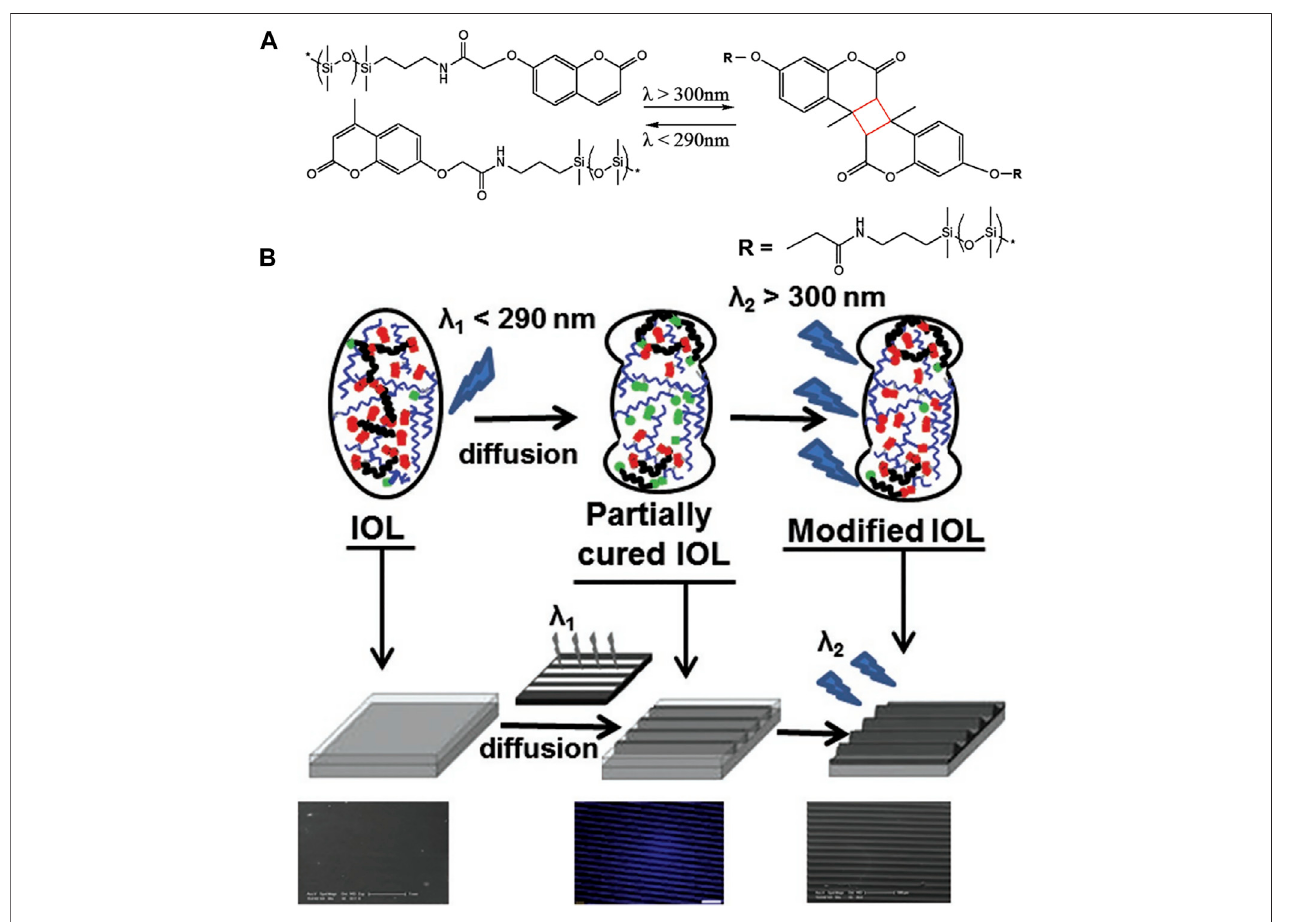
FIGURE3|(A) Schematicofphotoreversiblecrosslinking ofPDSM-coumarinpolymer. (B) SchematicofdesignedIOLfromJellaliet al.(2017),withthepermission of Wiley.